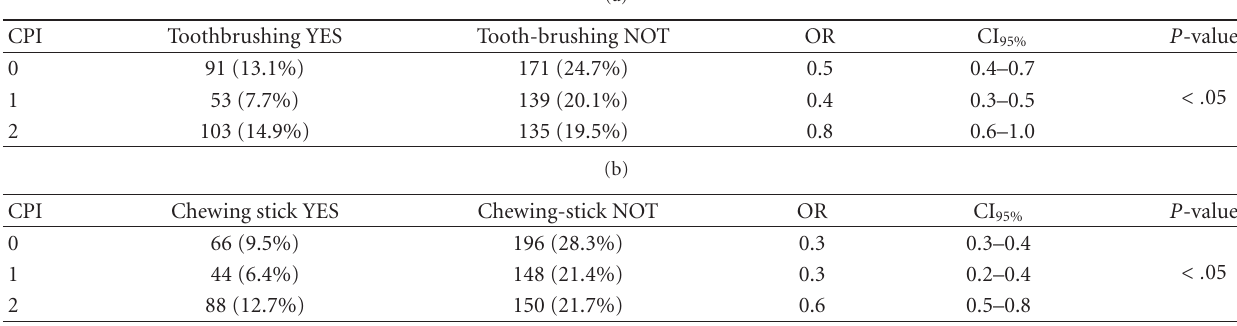
Table 3: Community Periodontal Index as count (percent) and odds ratio (OR) for each score according to toothbrushing habit and chewing stick